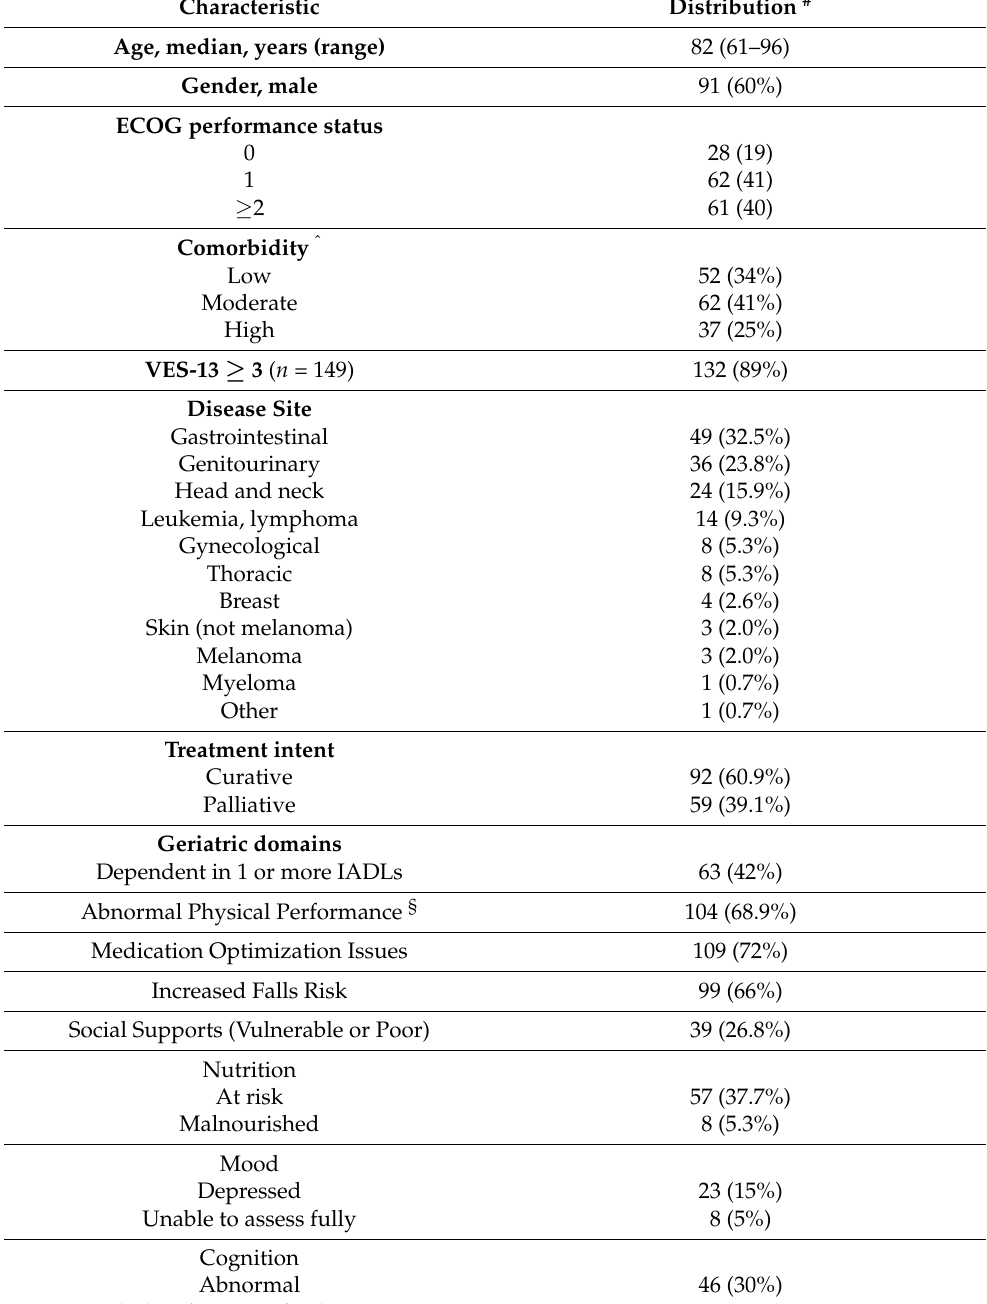
Table 2. Baseline characteristics of patients seen pre-treatment and included in the cost analysis (n = 151